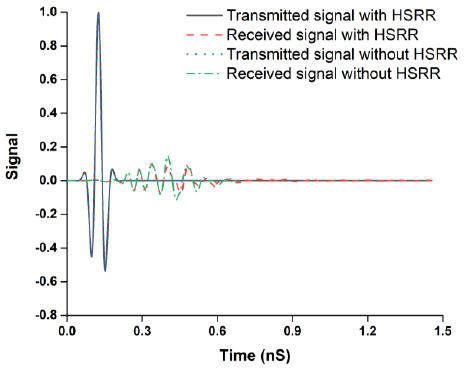
Figure 12. Transmitted and received signals without and with HSRR.